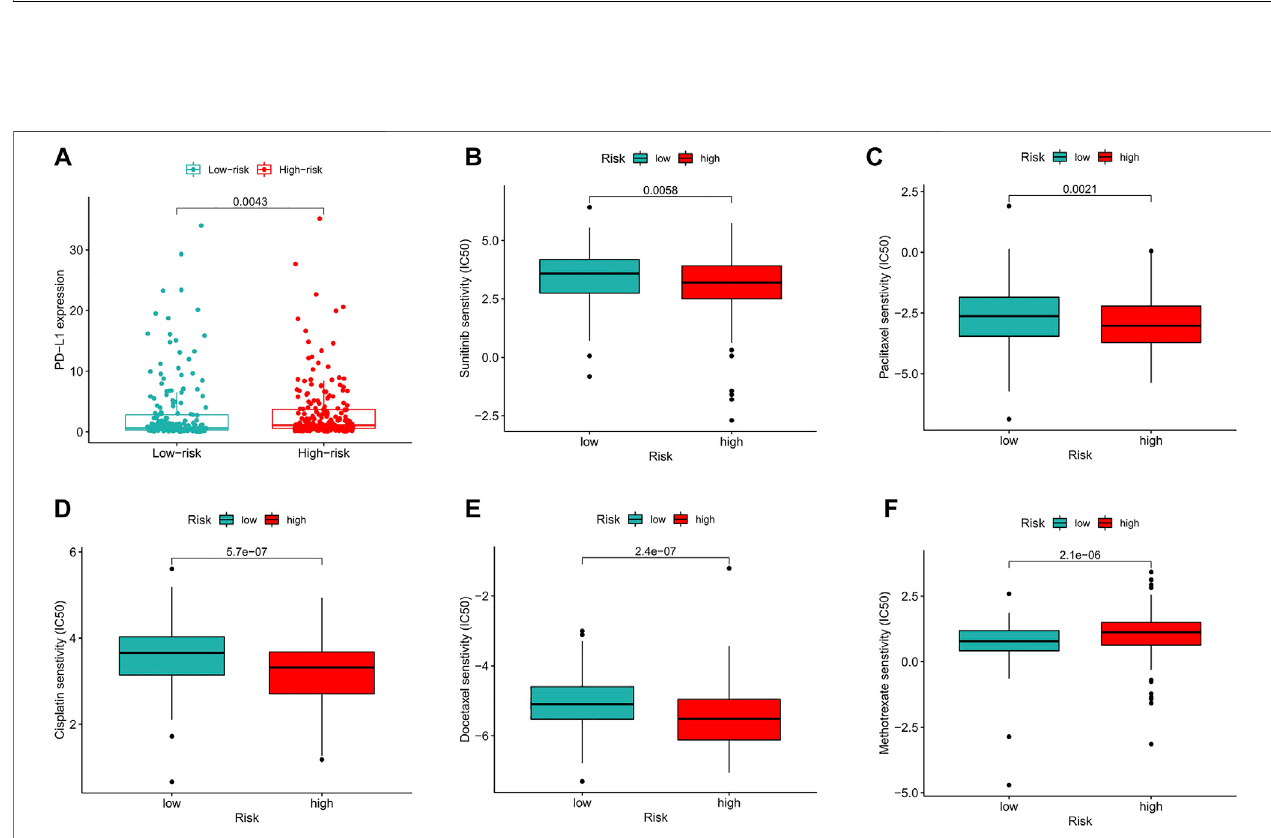
FIGURE 10| Comparison oftreatment drugs senstivity between high- and low-risk groups. (A) PD-L1 expression in high and low risk groups. (B) IC50 of sunitinib in high and low risk groups. (C) IC50 of paclitaxel in high and low risk groups. (D) IC50 of cisplatin in high and low risk groups. (E) IC50 of docetaxel in high and low risk groups. (F) IC50 of methotrexate in high and low risk groups. IC50, half-maximal inhibitory concentration. PD-L1, programmed cell death ligand 1.